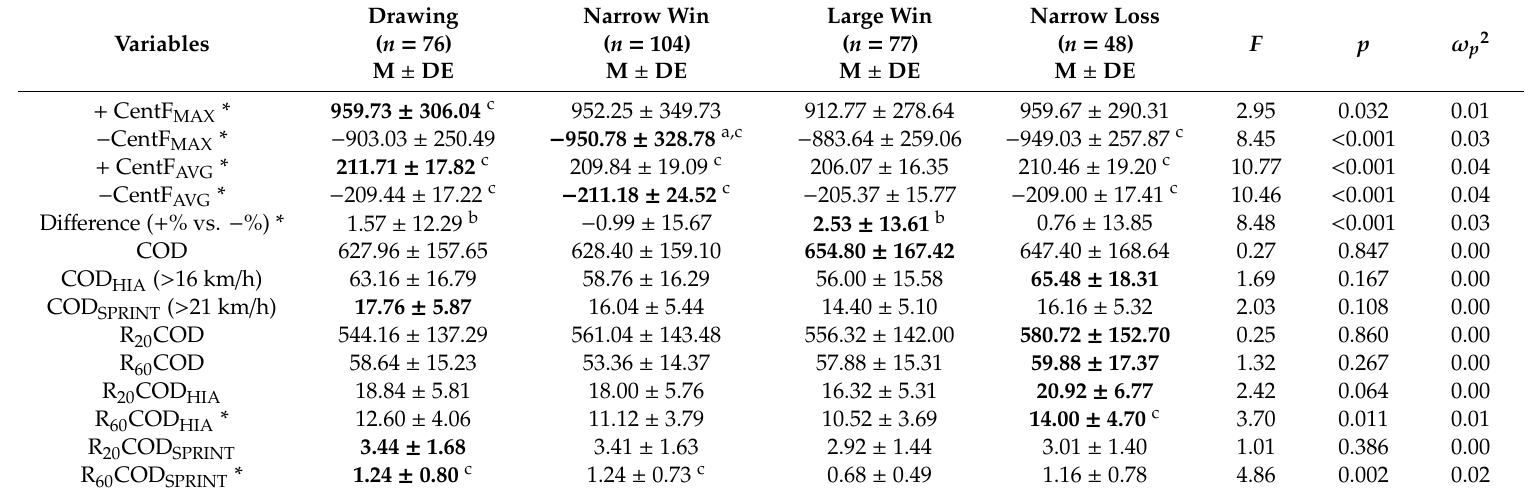
Table 4. Descriptive and comparative analysis of centripetal force and changes of direction related to the match outcome.